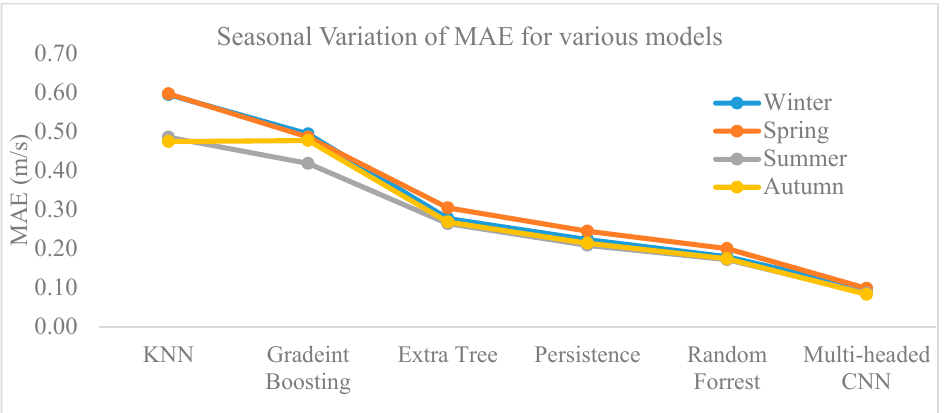
Figure 8. Seasonal variation of MAE for forecasting wind speed.